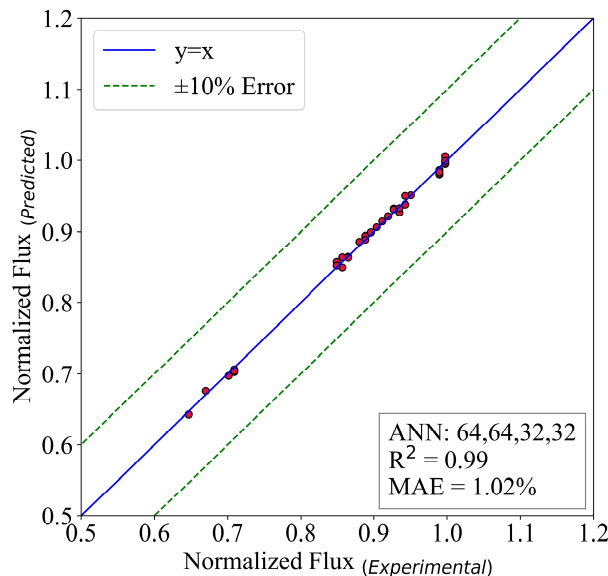
Figure 11. The predictive model for normalized flux.